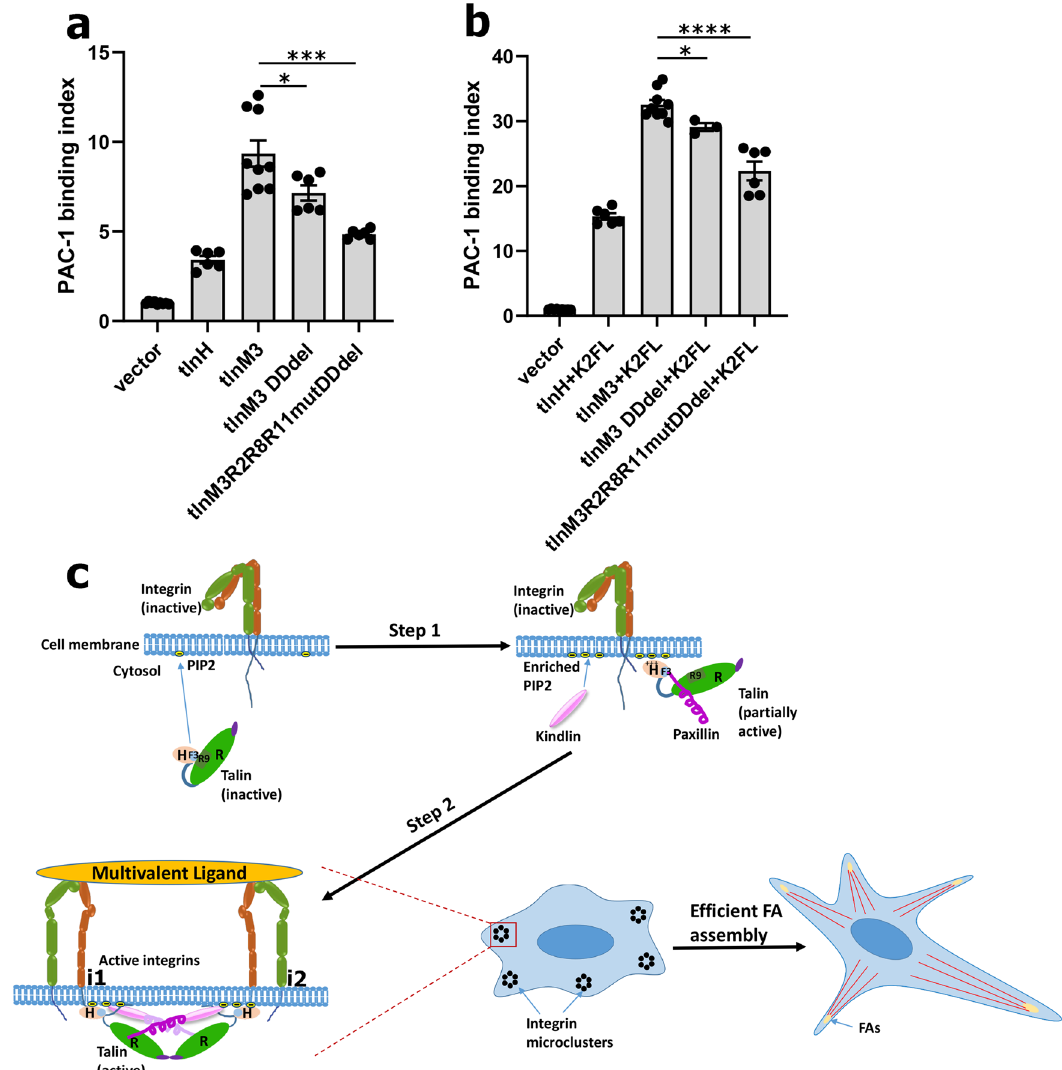
Fig. 7 Both talin dimerization and talin – paxillin – kindlin pathway contribute to integrin activation. a PAC-1-binding assay showing that integrin activation by full-length active talin (tlnM3) was reduced by deletion of talin-dimerization domain (tlnM3 DDdel), and addition of paxillin-binding mutations (tlnM3 R2R8R11mut) further reduced PAC-1 binding to almost the level caused by talin head (tlnH) only. * p = 0.0416 with 95% con fi dence interval − 4.267 to − 0.0963 ( t -test); *** p = 0.0003 with 95% con fi dence interval − 6.453 to − 2.529; N = 6 biologically independent samples. Values are shown as mean ± S.E.M. b Synergy between intact kindlin-2 and intact active talin (tlnM3 + K2FL) was signi fi cantly impaired by DDdel as shown by reduced PAC-1 binding. Combination of paxillin-binding de fi cient mutations and DDdel mutation further substantially reduced PAC-1 binding. * p = 0.0286 with 95% con fi dence interval − 6.485 to − 0.4448 ( t -test), N = 3 biologically independent samples; **** p < 0.0001 with 95% con fi dence interval − 13.40 to − 7.084 ( t -test), N = 6 biologically independent samples. Values are given as mean ± S.E.M. c A model for dynamic integrin-activation process where inactive talin fi rst engages with PIP2 to initiate, via talin-H, the conformational opening of talin, which initiates the recruitment of paxillin (Step 1). At Step 2, activated talin dimer, while anchored to PIP2 membrane, clusters two conformationally open integrins ( i1 and i2 ) via each talin monomer subunit. Meanwhile, talin, which is bound to integrin i1 , links, via paxillin, to kindlin that is bound to another integrin i2 . Such talin – paxillin – kindlin linkage (primarily driven by talin-R as shown in the text) strengthens the talin-dimer-induced microclustering of integrins, leading to their potent multivalent binding and ef fi cient FA assembly for cell adhesion. a , b Raw data are provided in Source Data fi LD motif (Supplementary Fig. 9a), and the docking program cannot specify the are solvent-exposed neighbors to “ active ” residues, were de fi ned automatically by interacting residue groups without unambiguous distance constraints. Examining HADDOCK server. Ambiguous interaction restraints (AIRs) were de fi ned between the remaining clusters reveals complex structures more or less similar to cluster the active residues of talin R2 and paxillin LD2. Eleven clusters with at least 1 or 2. 4 structures in each cluster were generated and included total 147 structures out of the fi nal 200 calculated from HADDOCK server, which represents 73% of the water-re fi ned models. The statistics of each cluster is summarized in Supplemen- tary Table 3. Overlaying all the models in the fi rst two clusters that have the best Haddock score and contain the most structures shows a converged ensemble with heavy atoms RMSD 0.31 ±0.11 Å and 0.26± 0.10Å, respectively. Examining the representative model in each of these two clusters shows that paxillin-LD2 struc- tures are similar but with opposite direction with respect to talin R2 domain. This is likely due to the highly symmetrically positioned Leu residues in the sequence of